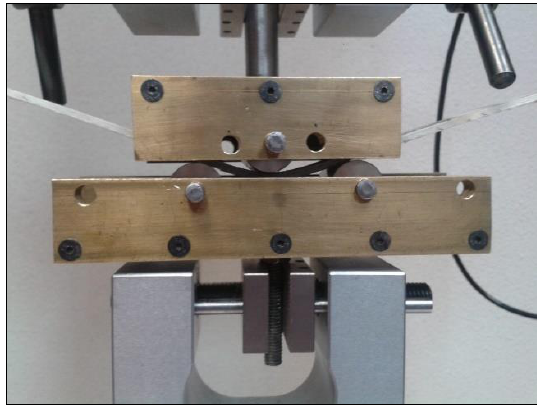
Figure 4. Three-point Bending test.